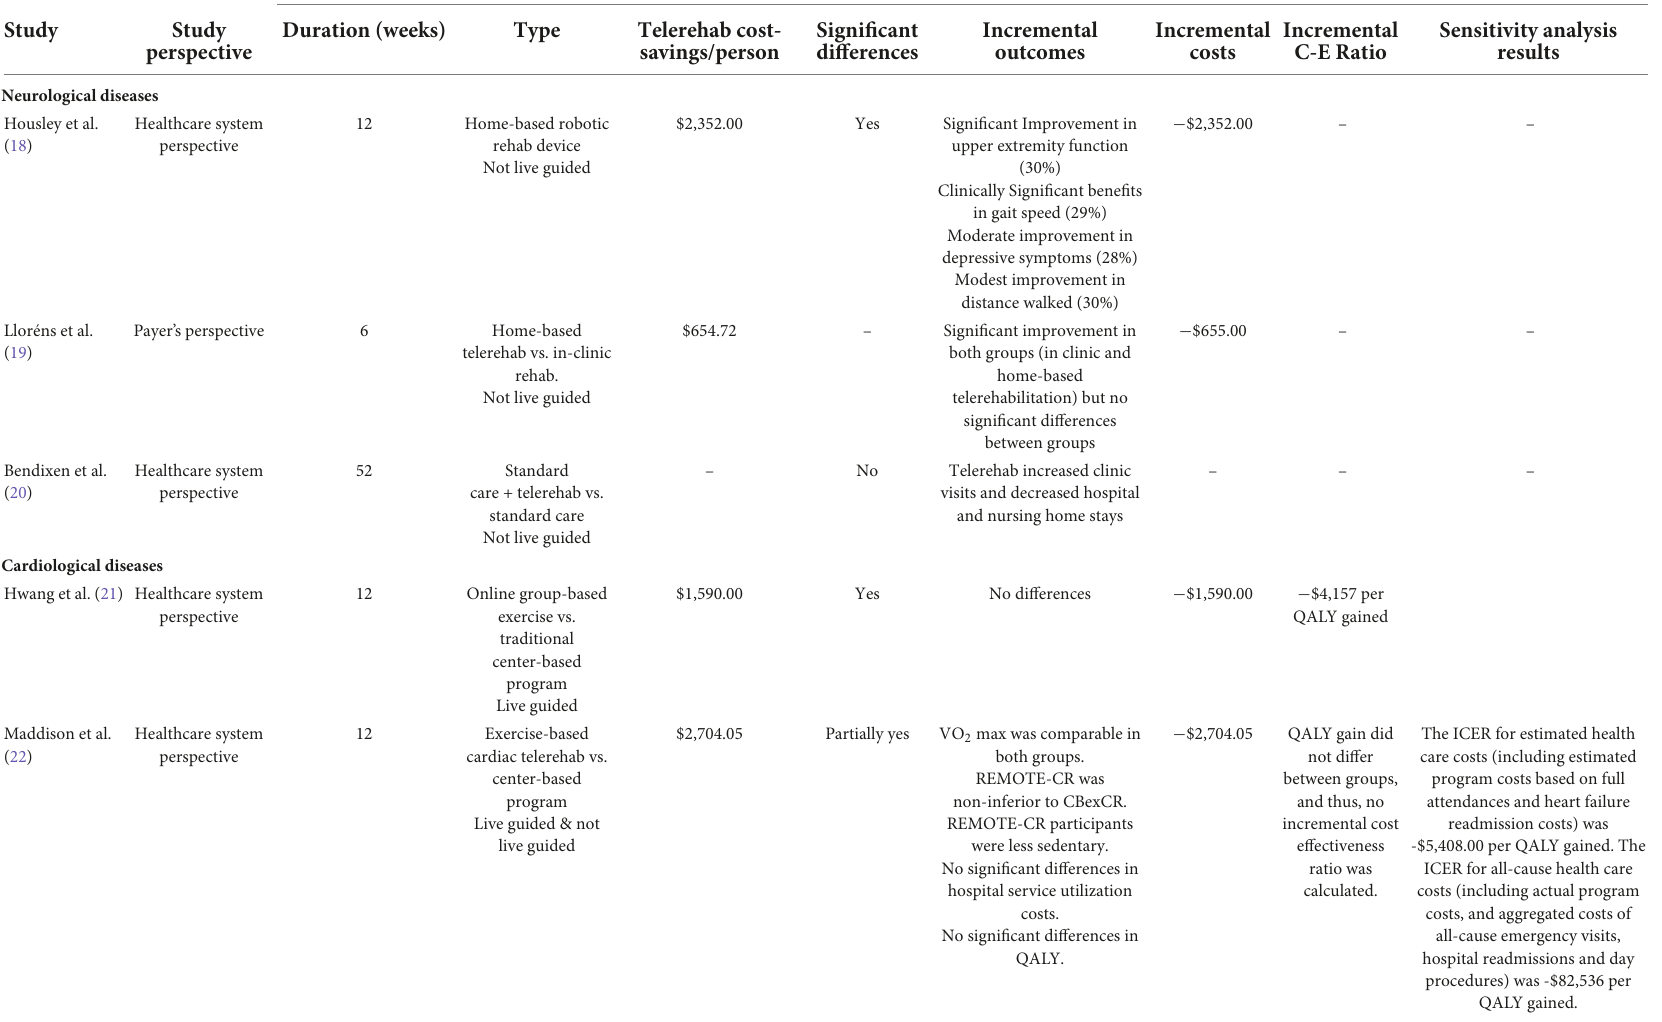
TABLE 2 Summary of telerehabilitation characteristics and study